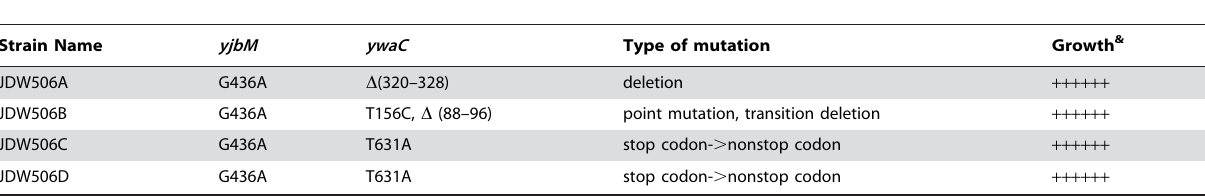
Table 5. Generation of secondary suppressor mutations in relA- yjbM*